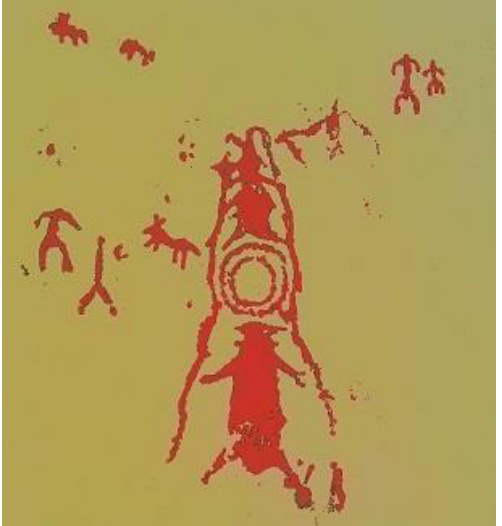
Figure 3. Representation of an ink drawing by the author of paintings within the chamber of Anta da Arquinha da Moura, showing the movement of caprids through a confined space.